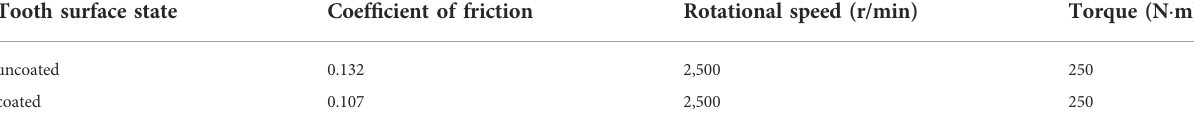
TABLE 6 Table of gear operating conditions.